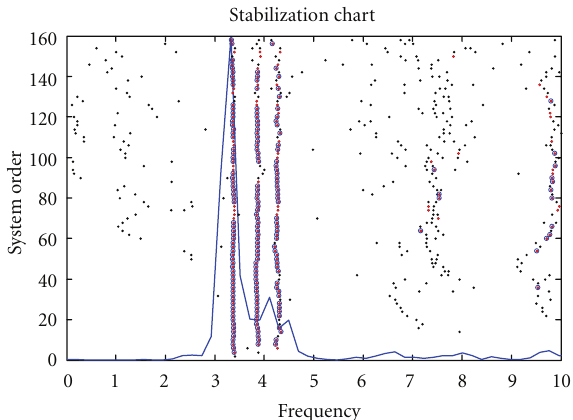
Figure 9: Typical stabilization chart showing stable modes (superimposed by power spectral density curve).